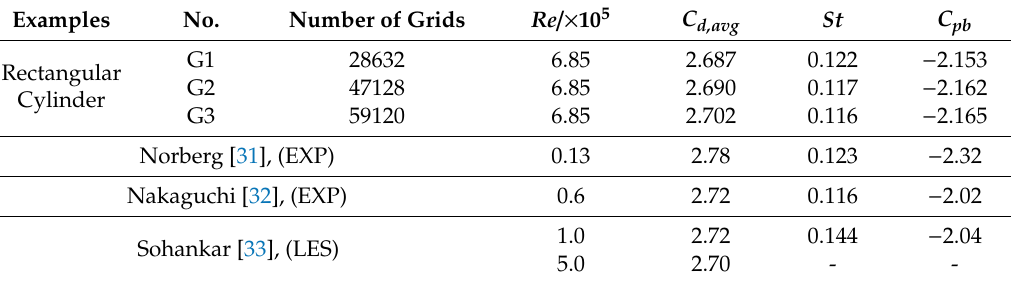
Figure 6. Non-uniform grid of the cylinders in O-block type. ( a ) Global meshing and ( b ) O-block mesh refinement. Table 3. Comparison of numerical results.